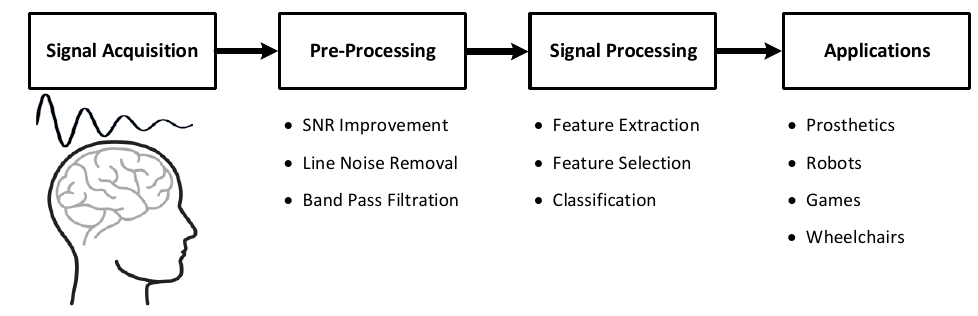
Figure 1. General overview of brain–computer interface (BCI)